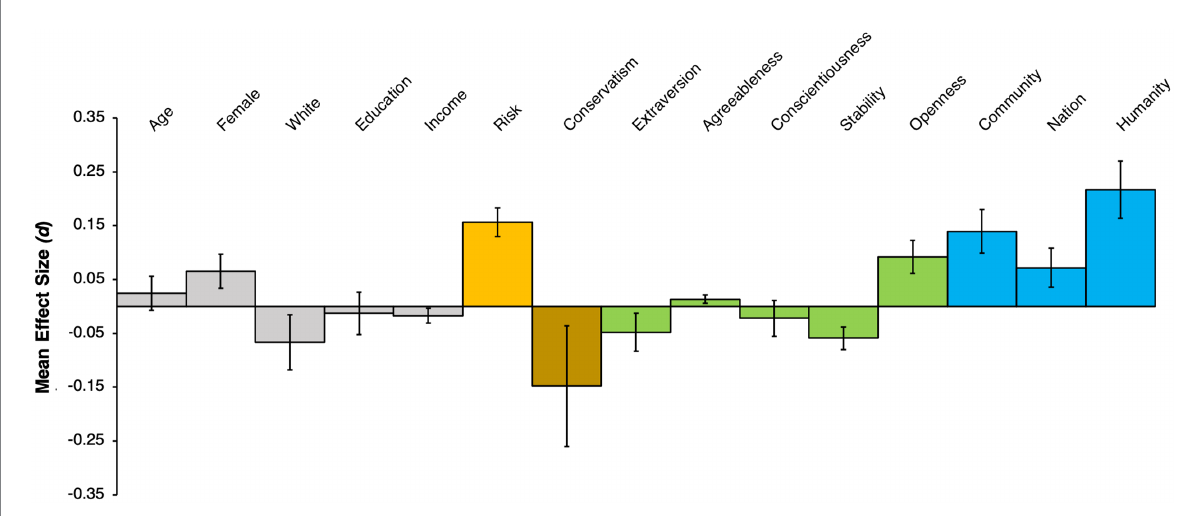
FIGURE 1 Mean effect sizes (estimated Cohen’s d ) of predictor variables for prosocial health behaviors across three studies. The predictors are grouped into five classes (indicated by color): demographics (grey), high risk (orange), conservativism (brown), Big 5 personality dimensions (green), identification with community, nation, and all humanity (blue). See main text for definitions of each variable. Positive values indicate that the predictor is associated with a higher score for the prosocial health behavior outcome measure. Error bars represent the standard error of the mean effect